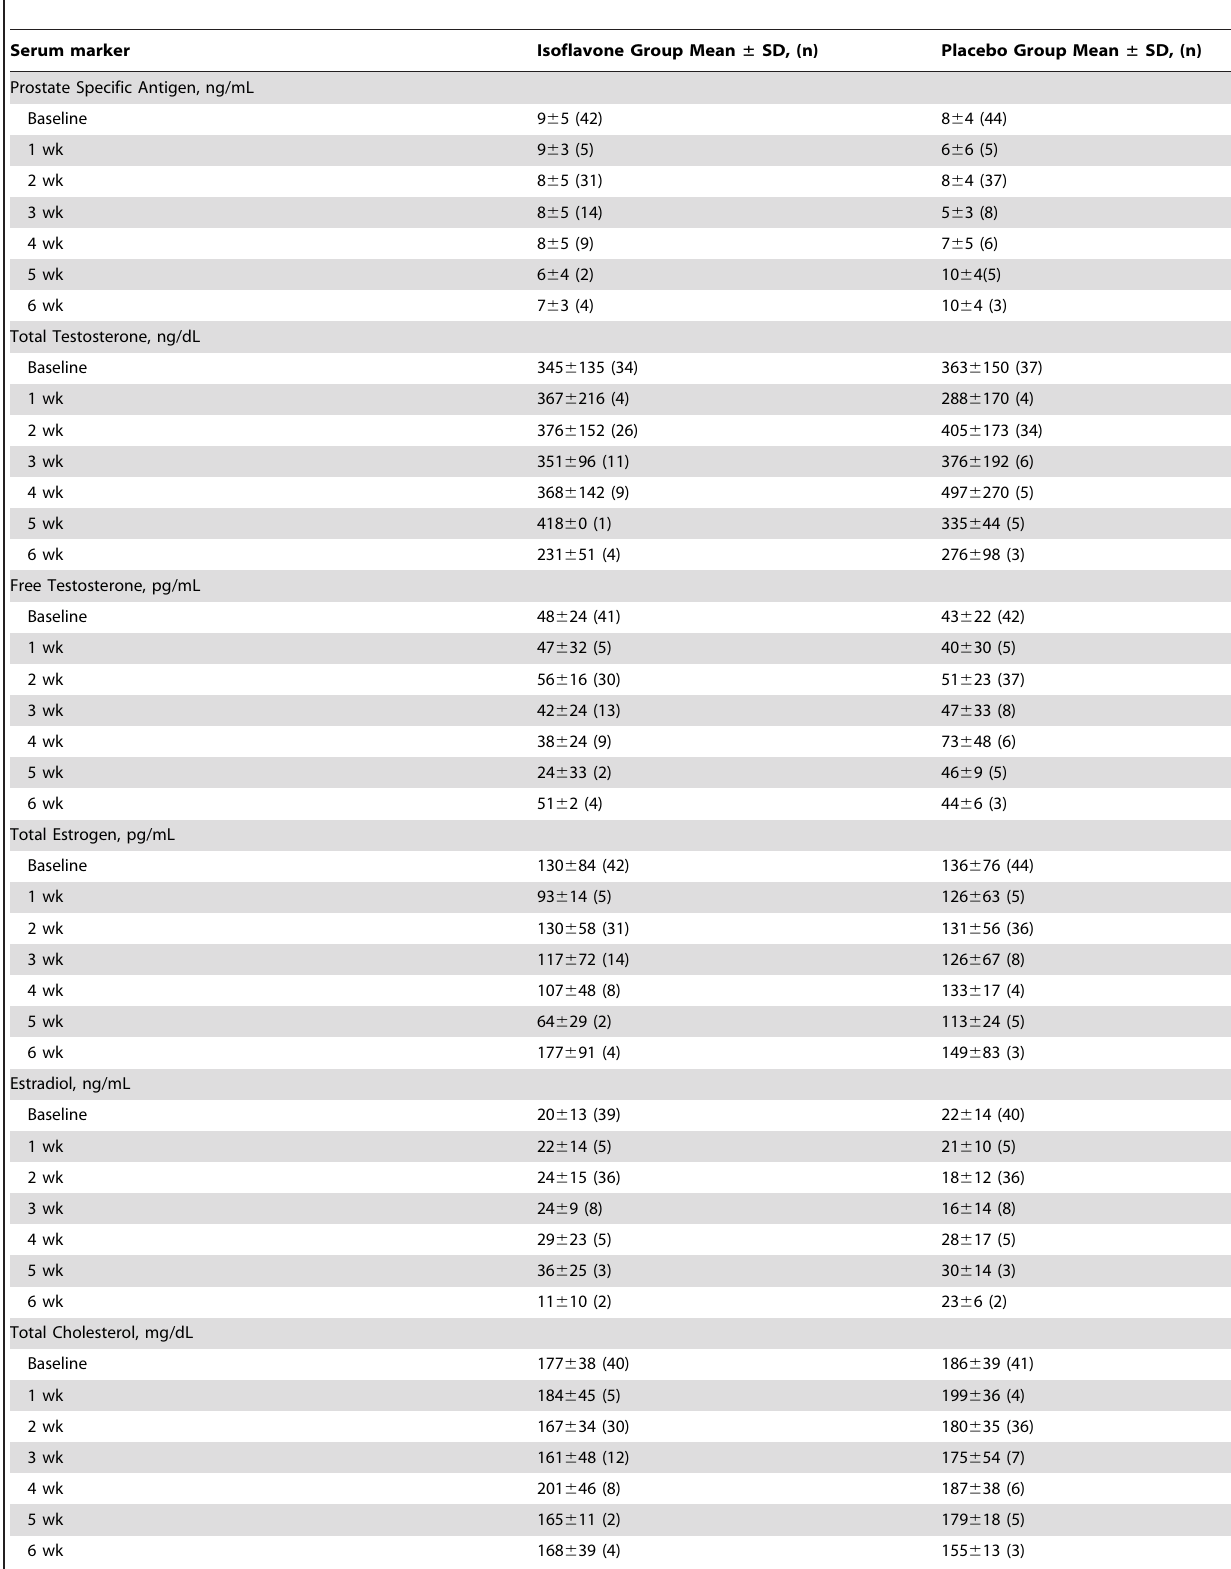
Table 2. Prostate Specific Antigen, Serum hormones, and Total Cholesterol in men with prostate cancer who consumed isoflavones or placebo for up to 6